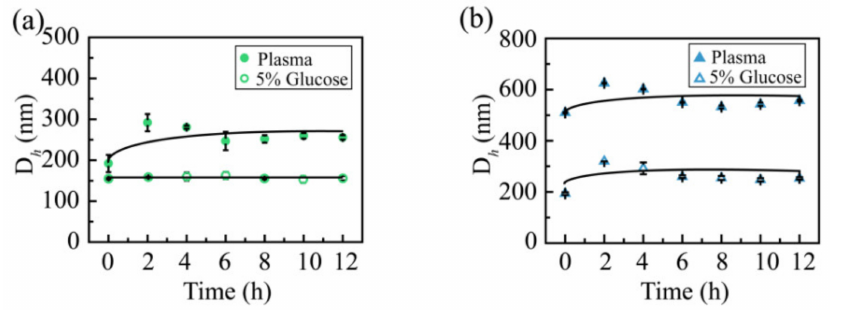
Figure 7. Particle size of the CSL-G2 NPs ( a ) and CSL-G2-C18 NPs ( b ) in glucose solution (5%) and